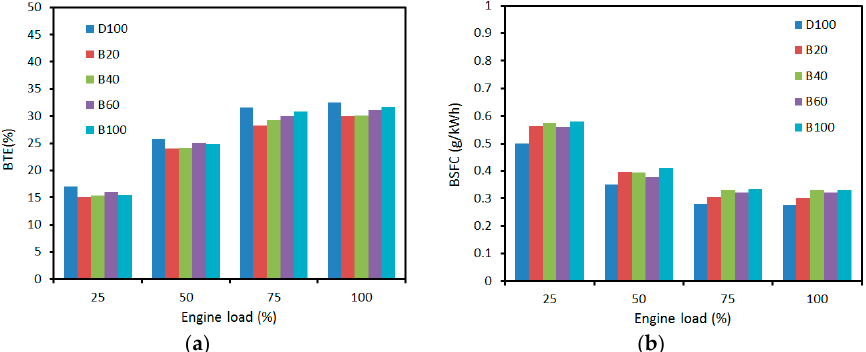
Figure 13. ( a ) Brake thermal efficiency (BTE) and ( b ) brake specific fuel consumption (BSFC) of canola oil biodiesel blended with diesel for various engine loads.